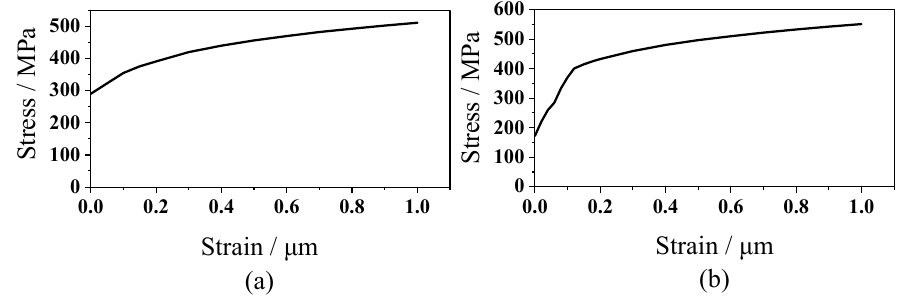
Figure 4. The stress–strain relationship of materials used in modeling. ( a ) AL2117-T4; ( b ) AL2024-T3. Table 2. Material properties for rivet and sheets used in modeling.